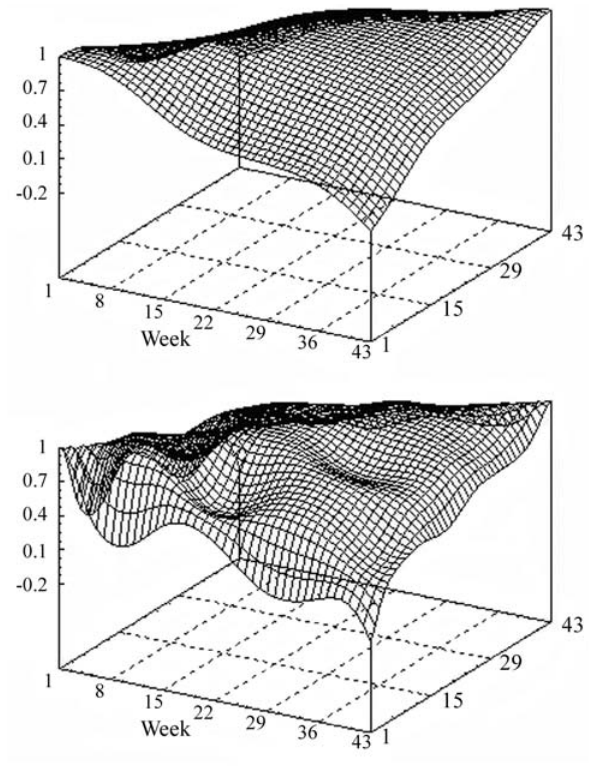
Figure 5 - Estimates of genetic correlations between TDMY obtained with 4,6,vf6 (above) and 6,6,vf6 (bellow) random regression